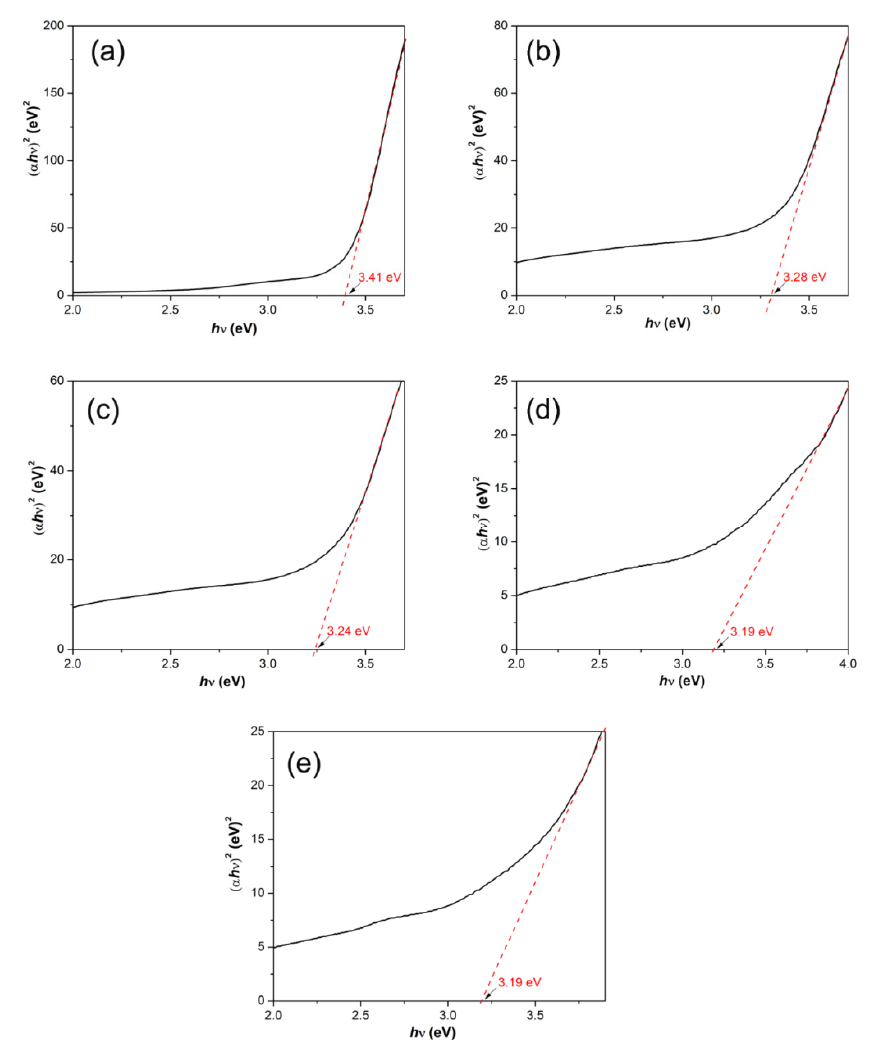
Figure 3. Energy bandgap of the G. mangostana L. leaf extract-mediated synthesized CuO NPs calcinated at ( a ) 200 ◦ C, ( b ) 300 ◦ C, ( c ) 400 ◦ C, ( d ) 500 ◦ C and ( e ) 600 ◦ C using Tauc plot